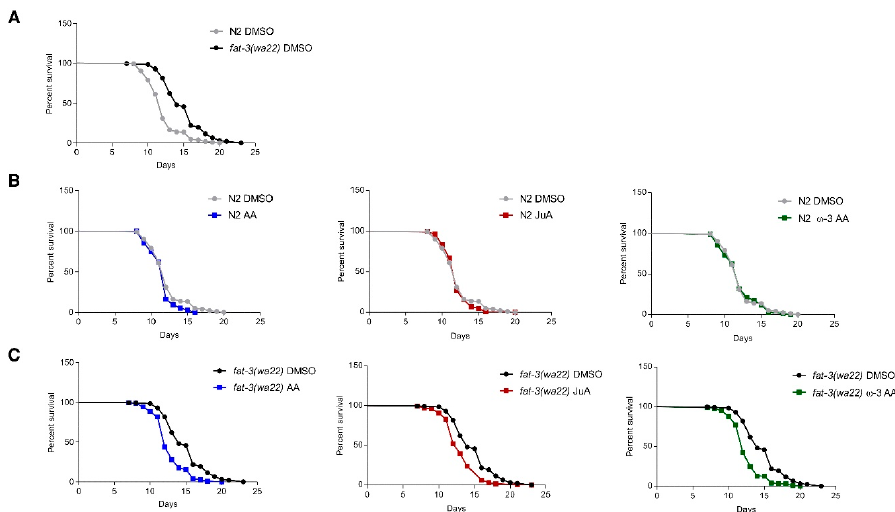
Figure 3. FAs supplementation leads to alteration in lifespans. ( A ) fat-3(wa22) mutants are significantly long-lived than N2 (WT) animals ( p < 0.0001). ( B ) N2 (WT) animal lifespans do not get significantly altered with supplementation of di ff erent FAs. ( C ) Lifespans of fat-3(wa22) mutants are significantly reduced (with supplementation of di ff erent FAs ( p < 0.0001). All assays were performed at 23 ◦ C with 50 µ g / mL FUDR. At least two biological replicate experiments were performed per condition.